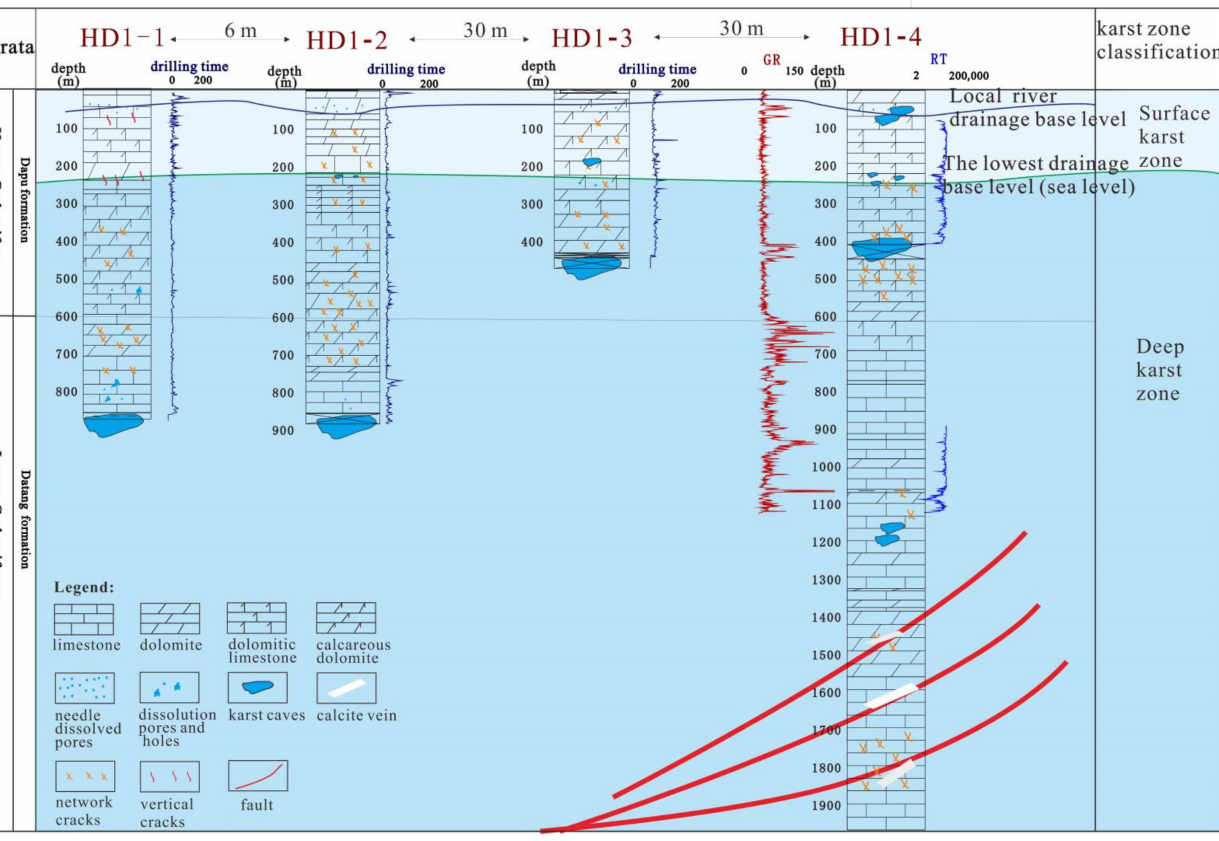
Figure 5. Comparison of deep karst caves developed in drills in Huanjiang sag. The locations of the four wells are shown in Supplementary Material Figure